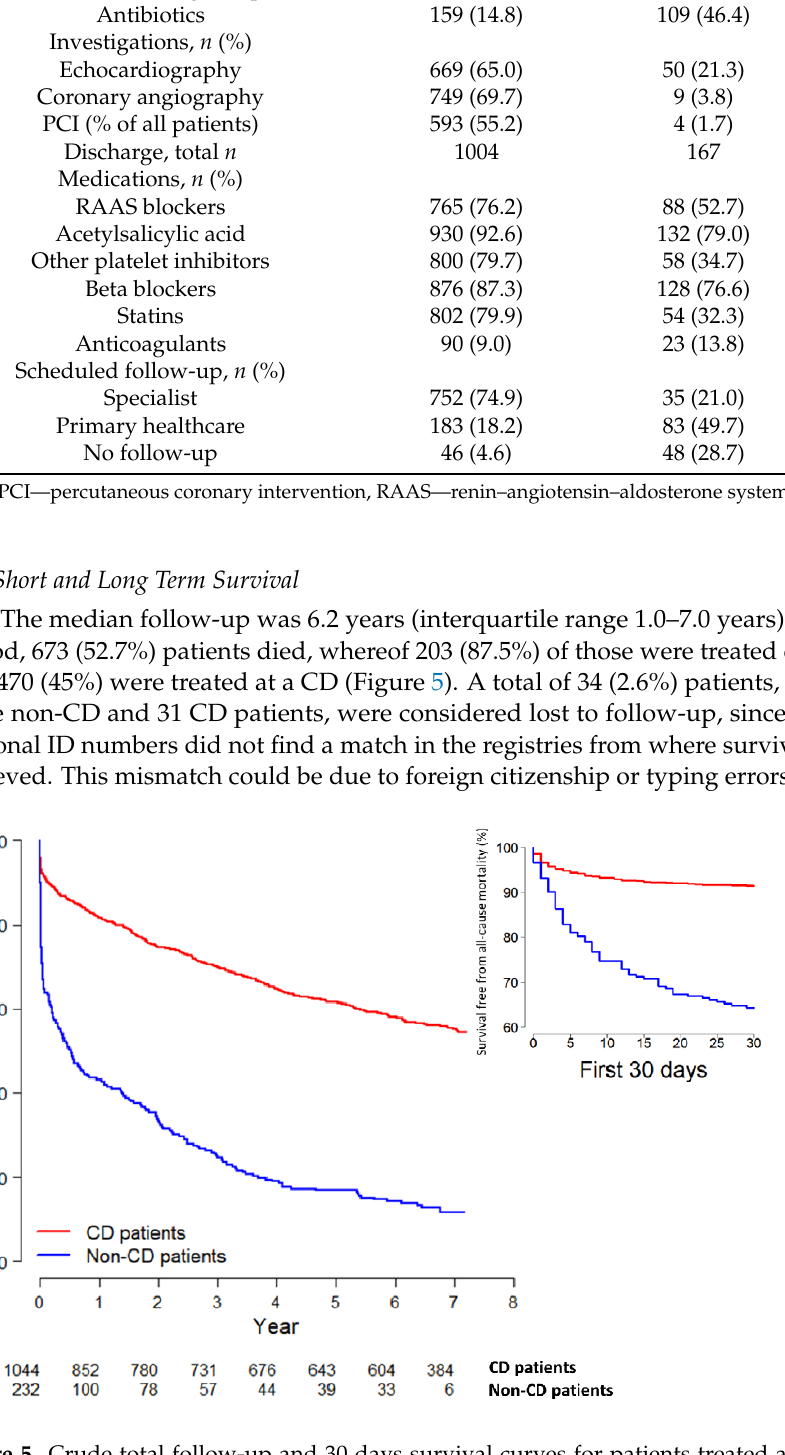
Figure 5. Crude total follow-up and 30 days survival curves for patients treated at a cardiology department ( red ) and patients treated outside a cardiology department ( blue ).